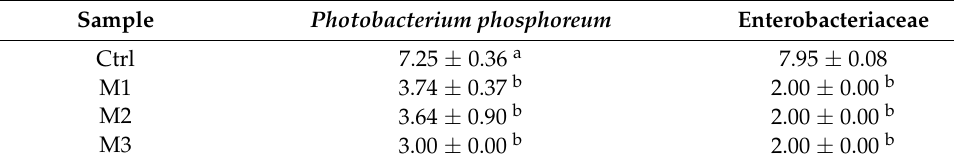
Table 2. Microbial counts (log CFU/g) of fish burgers after 26 days of storage.